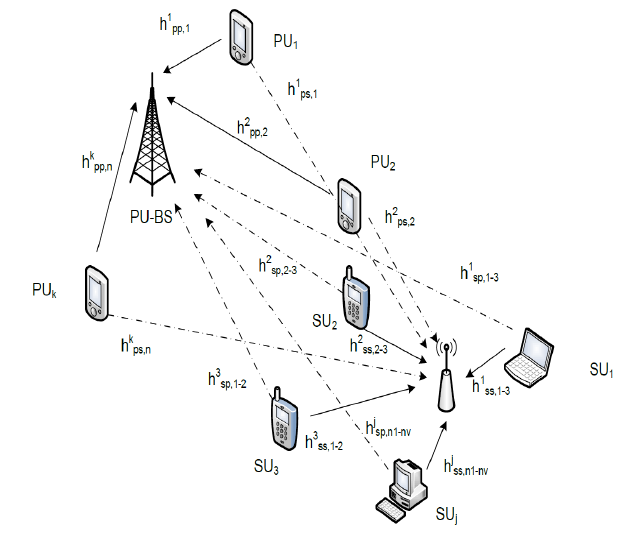
Figure 1. System model.